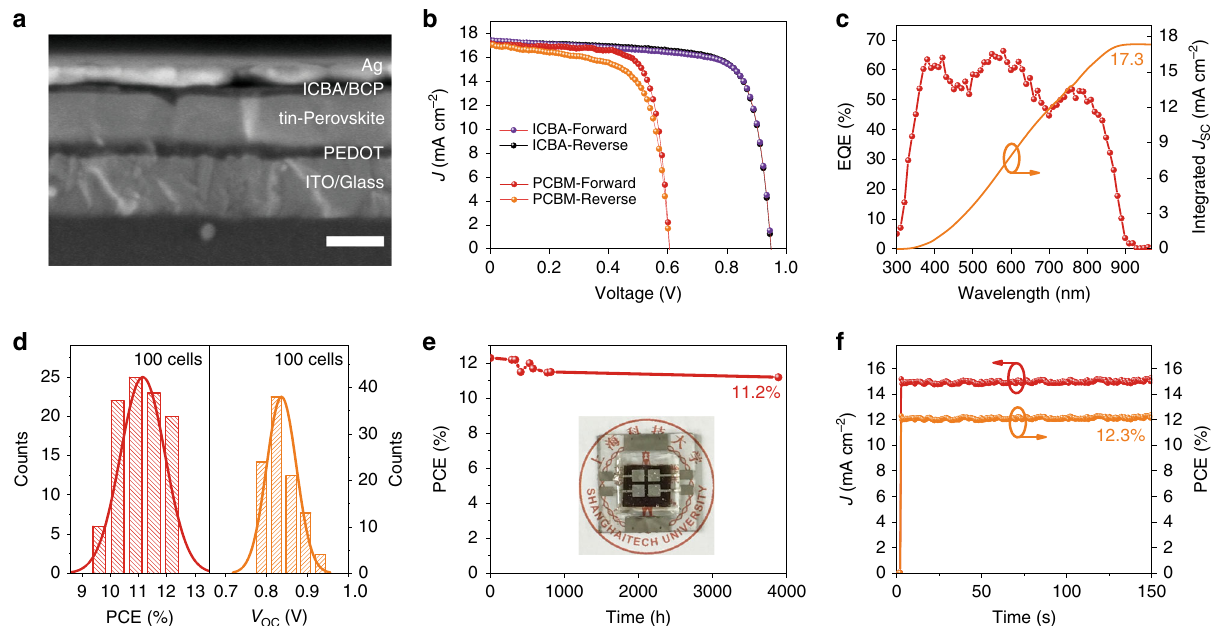
Fig. 3 Photovoltaic performances of tin PSCs. a Cross-section SEM image of PEA15-SCN device. The scale bar is 200 nm. b J – V curves of the certi fi ed PEA15-SCN device with ICBA and champion device of PEA15-SCN fi lm with PCBM. c EQE curve and integrated J SC of the certi fi ed PEA15-SCN device. d Histograms for PCE and V OC of PEA15-SCN device. e The stability of encapsulated PEA15-SCN device stored in N 2 atmosphere. f Stabilized power output for the PEA15-SCN device (at 0.81 V) under simulated AM 1.5 G solar illumination at 100 mW cm − 2 .